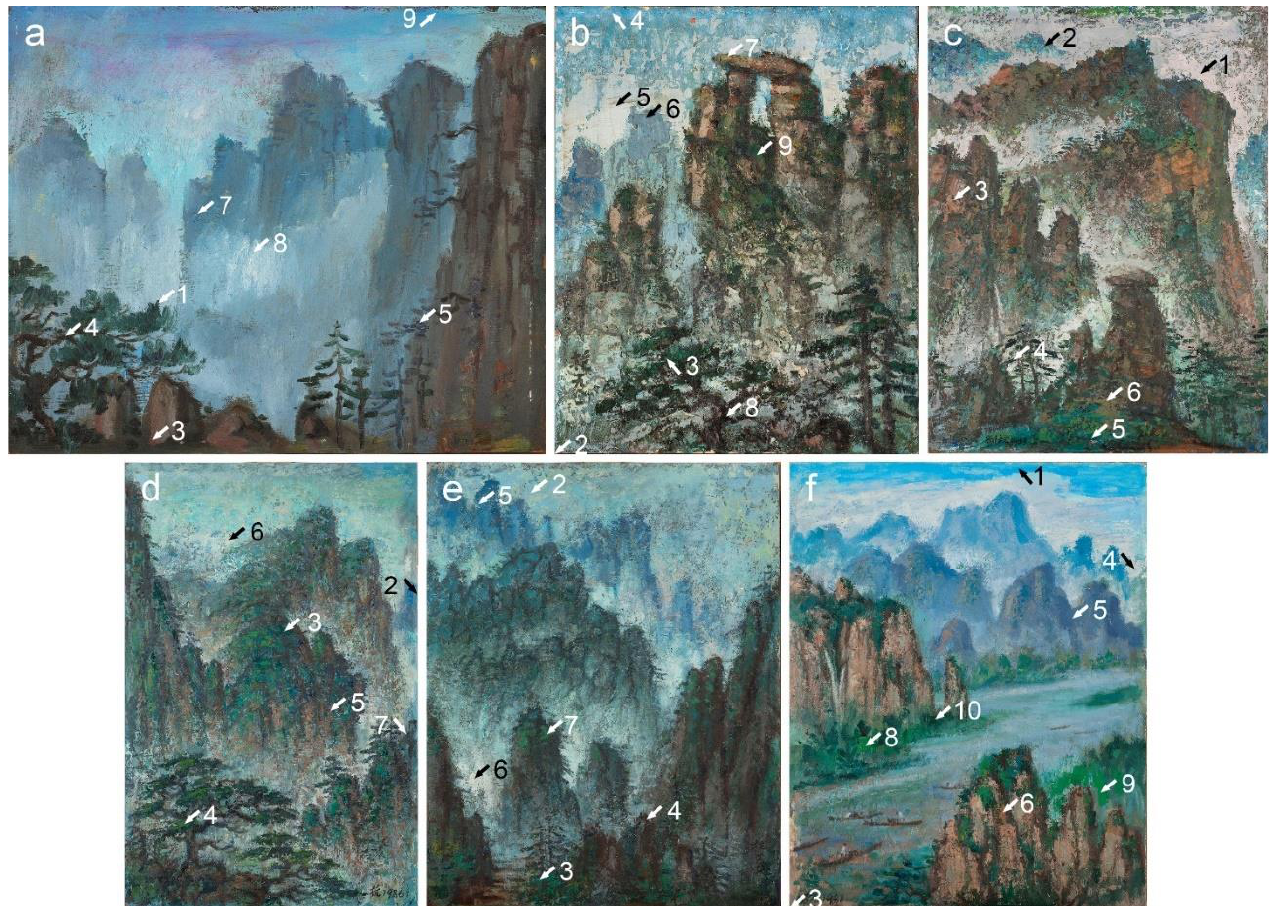
Figure 1. Paintings by Liu Kang: ( a ) Mountain , 1977, oil on board, 38 × 45.5 cm; ( b ) Mountain , 1981, oil on canvas, 36 × 29.5 cm; ( c ) Mount Huangshan , 1983, oil on board, 84.6 × 64.5 cm; ( d ) Mount Huangshan , 1986, oil on board, 74 × 48.5 cm; ( e ) Mount Huangshan , 1987, oil on board, 71 × 55.6 cm; ( f ) Mountains , 1991, oil on canvas, 76.5 × 61 cm. Gifts of the artist’s family. Collection of National Gallery Singapore. Arrows and numbers indicate sampling areas.